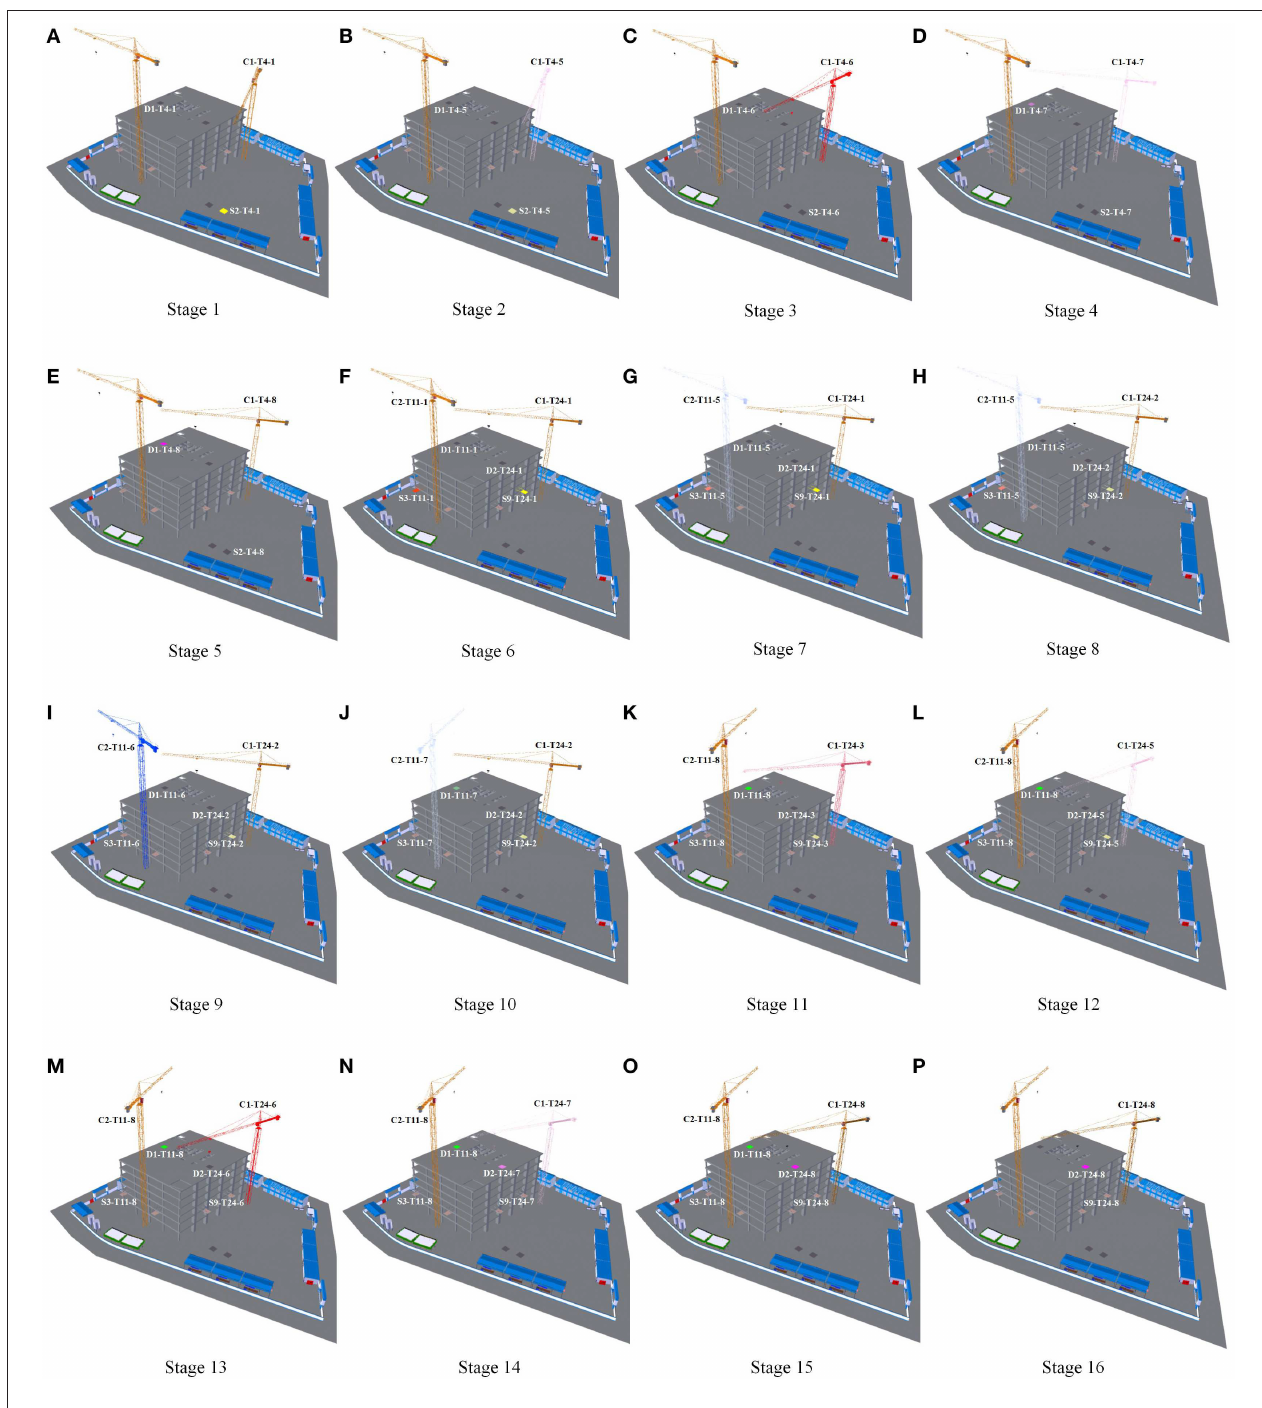
FIGURE 6 | 4-D simulation adopting the fine-level scheme [ (A–P) are Stages 1 to 16, respectively].